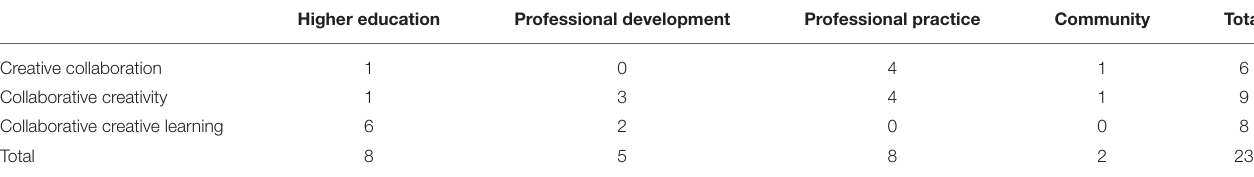
TABLE 9 | Phenomenon of interest in each setting.